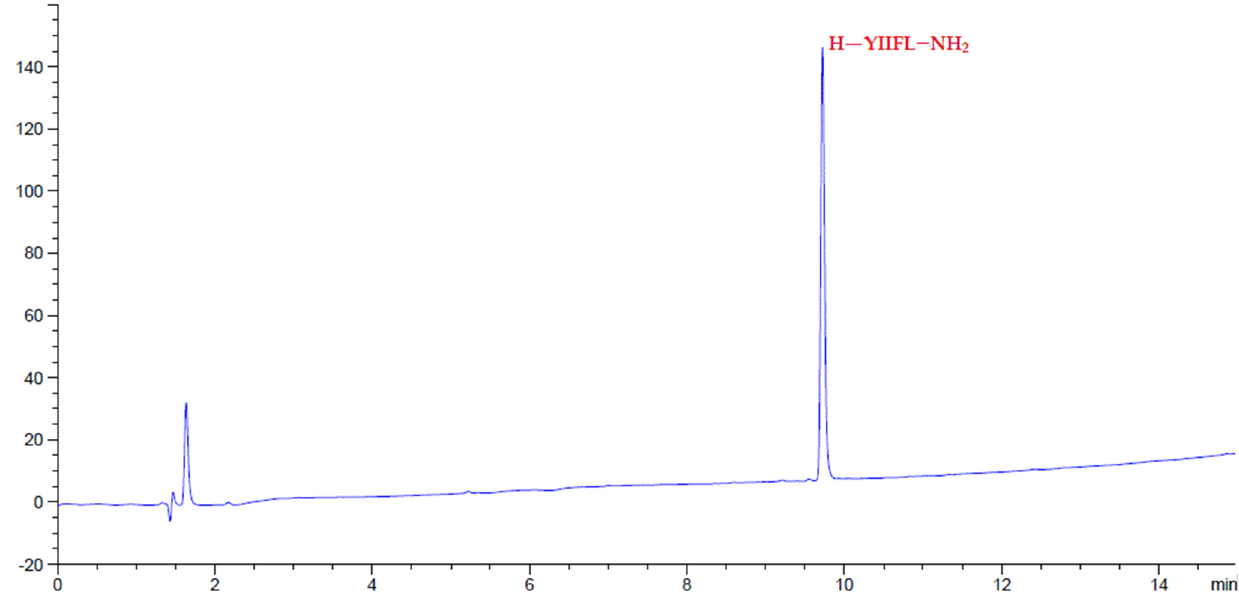
Figure 7. HPLC chromatograms of crude peptides H-YIIFL-NH 2 after precipitation.